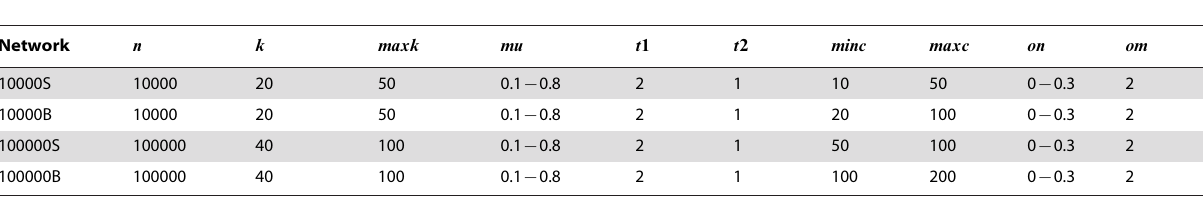
Table 3. The detailed parameters of the generated benchmark networks.